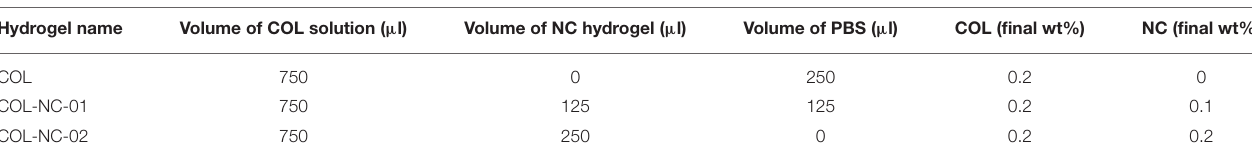
TABLE 2 | Collagen-nanocellulose hydrogel